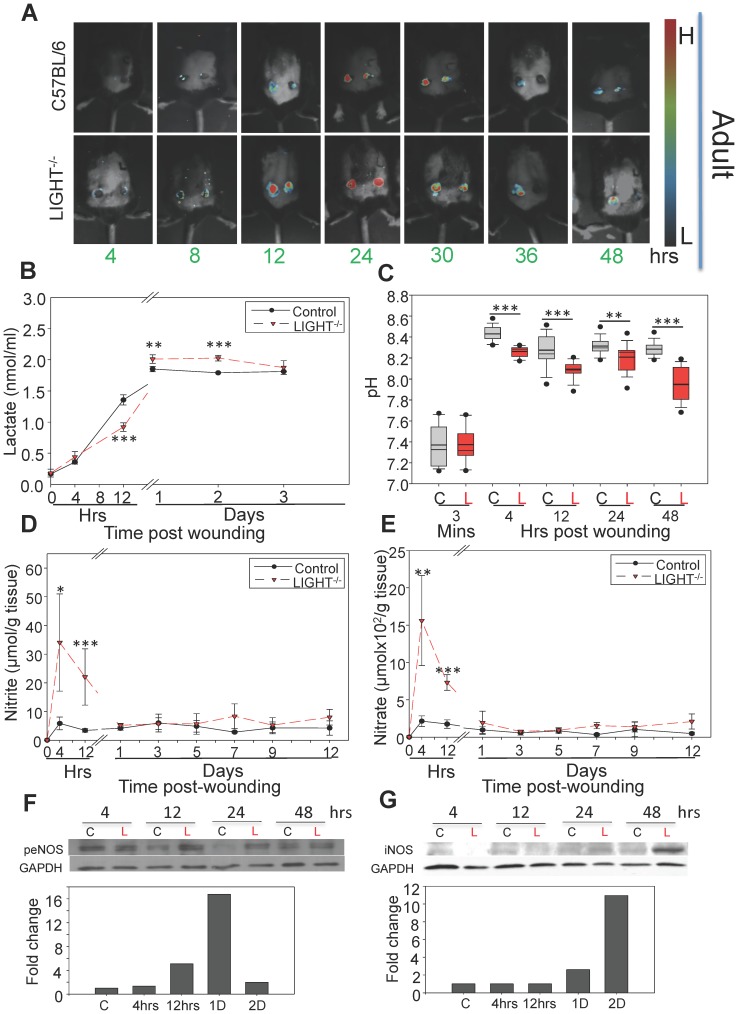
Microscopic, biochemical and chemical markers show imbalanced redox in LIGHT−/− mice.(A) In vivo imaging of ROS was carried out using the ImageEM 1K EM-CCD camera with an optical system consisting of a 50 mm f/1.2 lens. Signals were obtained around the periphery of the wound as early as 4 hrs post-wounding in the LIGHT−/− mice and significantly higher signals captured in LIGHT−/− mice peaked at 24 hrs post-wounding. (B) Lactate measurements: An oxidized intermediate was formed when extracted lactate reacted with a probe to give fluorescence detectable at 605 nm. There was significant increase in levels of lactate accumulation in LIGHT−/− mice at 24–48 hrs post wounding. n = 6. (C) pH levels were measured using a beetrode microelectrode and micro-reference electrode. The LIGHT−/− wounds were systematically more acidic than controls. n = 25. (D,E) Methanolic-extracted nitrite (D) and nitrate (E) were analyzed. Both were greatly increased in LIGHT−/− mice during early response to wounding. n = 8. (F-G) Phospho-eNOS levels and iNOS expression in LIGHT−/− wounds were examined by western blotting (representative experiment shown). Analysis by densitometry (normalized to C57BL/6 mouse wound). Time zero represents unwounded skin except in
Figure 2C
. All data are Mean ± SD. *p<0.05,**p<0.01,***p<0.001.